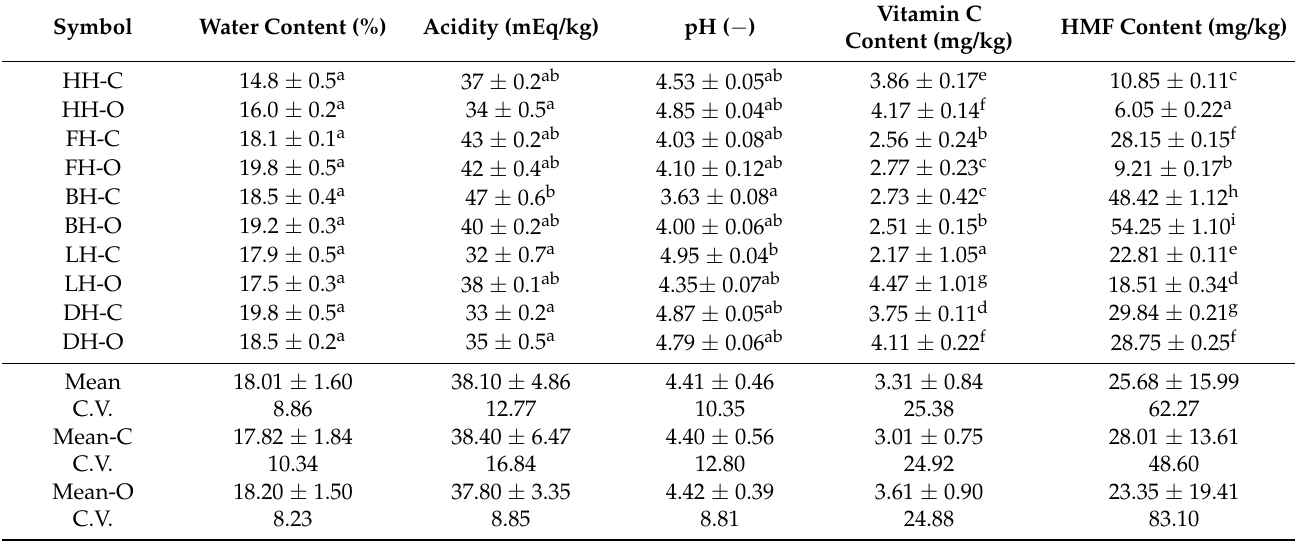
Table 1. Physicochemical parameters of honey samples (mean value and standard